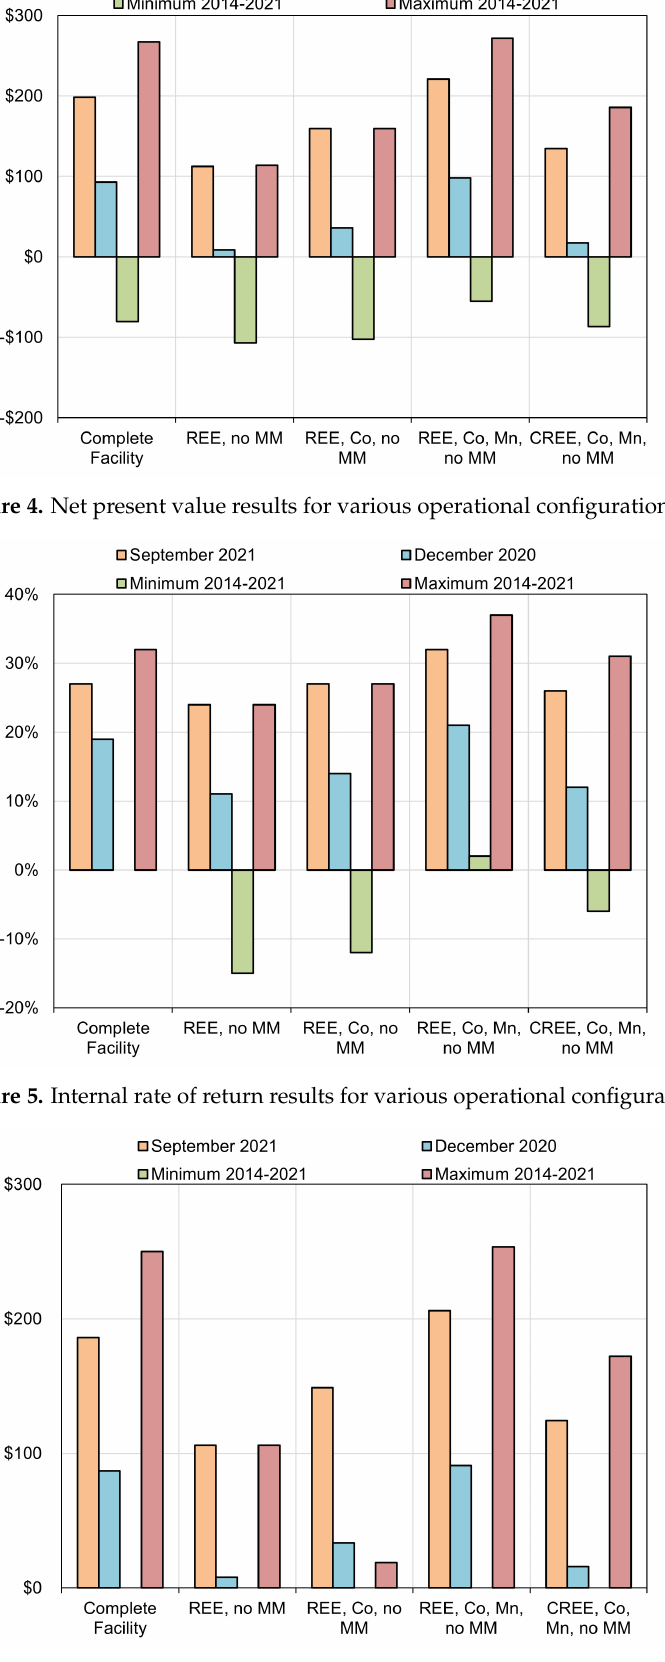
Figure 6. Pre-concentrate value results for various operational configurations and pricing